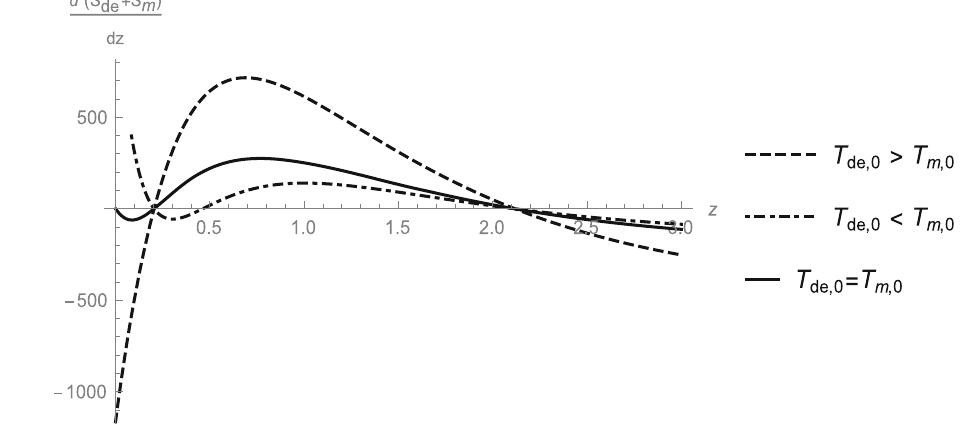
Fig. 8 Behavior for the total entropy of the system using the best fit values for the parameters of the model